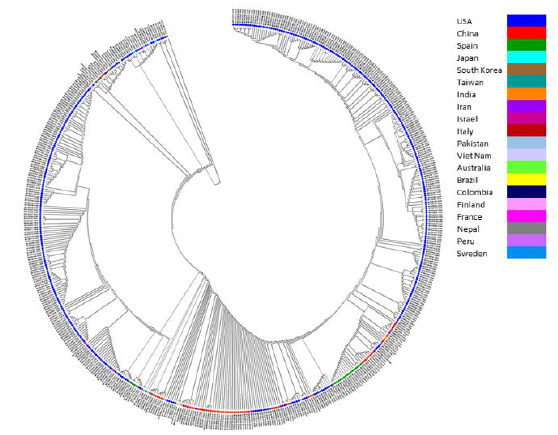
Figure 4. Circular cladogram of 540 genomes of SARS-CoV-2. The cladogram explains the base and spread of SARS-CoV-2 across 20 different countries/territories. The root node was found with an isolate from the Wuhan outbreak, China, and the spread was observed to other countries/territories in the order of USA, Japan, Israel, Pakistan, Iran, Brazil, South Korea, Italy, Spain, Sweden, Australia, Finland, France, Peru, Taiwan territory, Vietnam, India, Nepal, and Colombia.